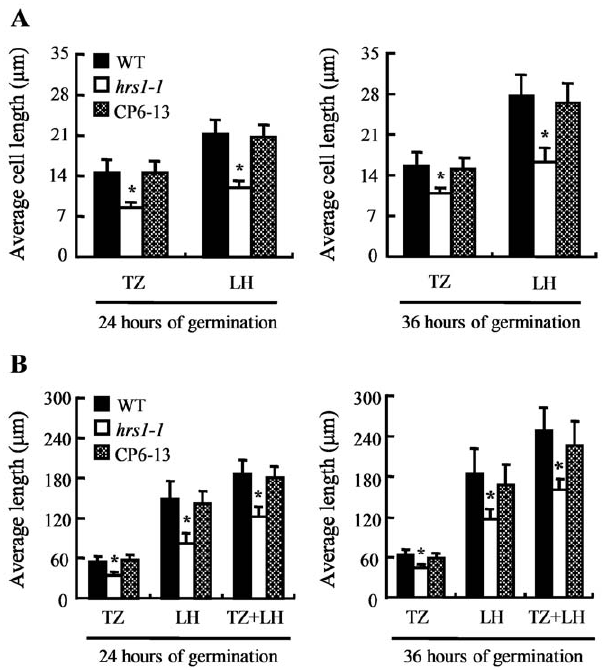
Figure 7. Examination of cell elongation growth in germinating embryo axis. The seeds of WT control, hrs1-1 and CP line (CP6-13) were cold stratified for 48 h, and then allowed to germinate on 1/2 MS medium at 23 u C. The measurements were made at 24 and 36 HOG, respectively. (A) The average cell length values (means 6 SD, n =30 , 35 samples measured per data point) in transition zone (TZ) and lower hypocotyl (LH) in WT control, hrs1-1 and CP6-13. The data displayed are representative of three separate experiments. (B) The average length values (means 6 SD, n =33 , 37 samples measured per data point) of TZ, LH, and TZ plus LH in WT control, hrs1-1 and CP6-13. The data shown are typical of three independent experiments. The additional CP lines (CP19-1 and CP23-3) behaved similarly as CP6-13 during these experiments. Asterisk indicates statistical significance from WT control and CP line at P # 0.05.